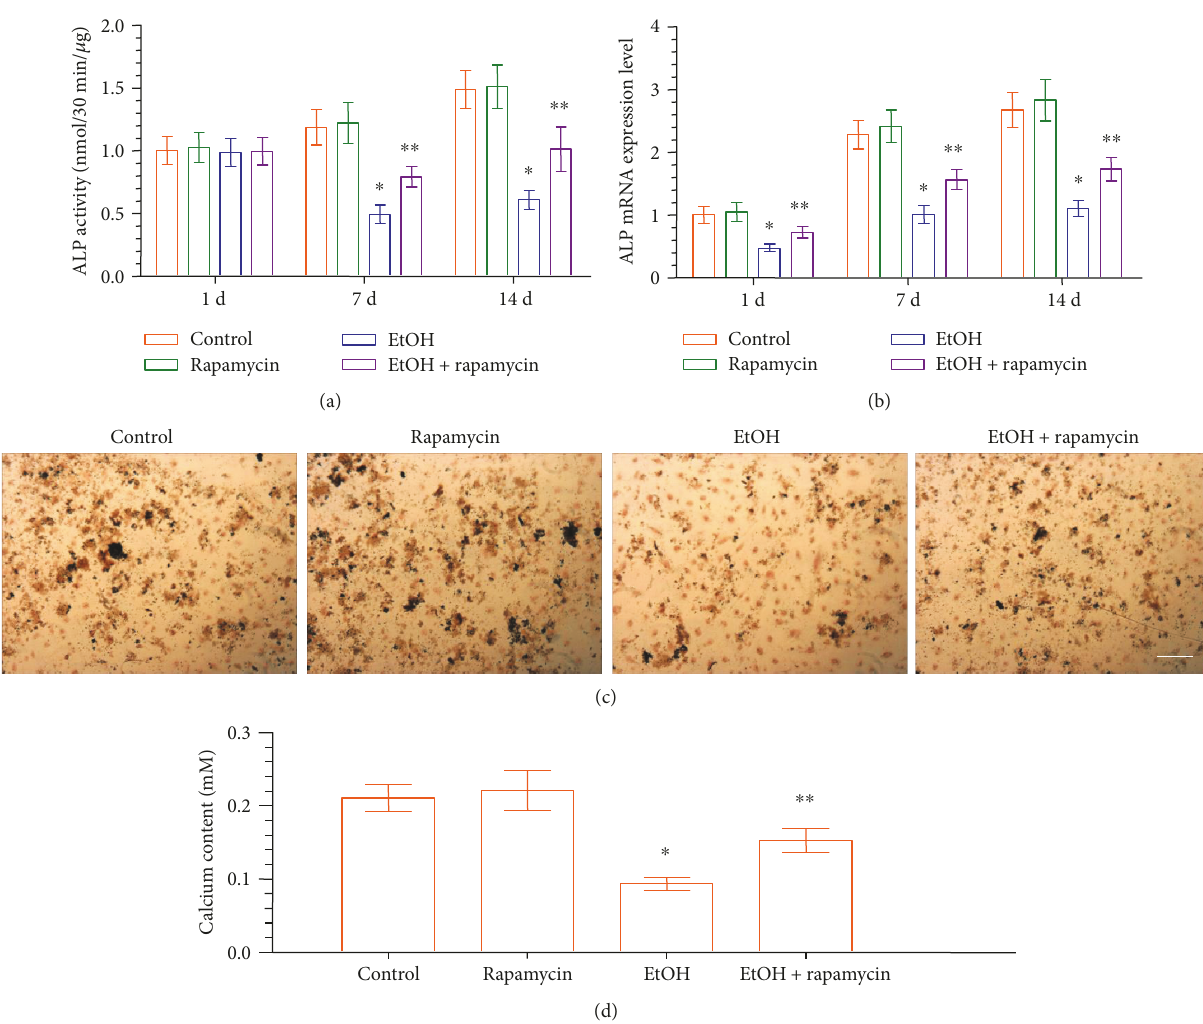
Figure 4: E ff ect of EtOH-induced ALP activity and mineralized nodule formation in DPCs. (a, b) DPCs were treated with EtOH (50 mM) in the absence or presence of rapamycin (50 mM, pretreatment for 1h). Cells were retreated every 3 days. ALP activity (a) and ALP mRNA expression (b) were measured at each time point. (c) DPCs were cultured in osteogenic induction medium for 14 days, and the mineralized nodule formation was assessed by von Kossa staining (scale bar =100 μ m). (d) On 14 days, the calcium content was determined. Data represent mean ± SD of 3 experiments with triplicates. ∗ p < 0 05 versus control group. ∗∗ p < 0 05 versus EtOH